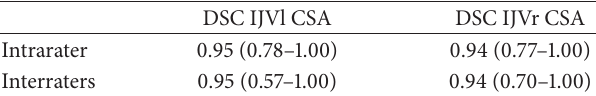
Table 3: Intrarater and interraters Dice similarity coefficient (DSC) expressed as median